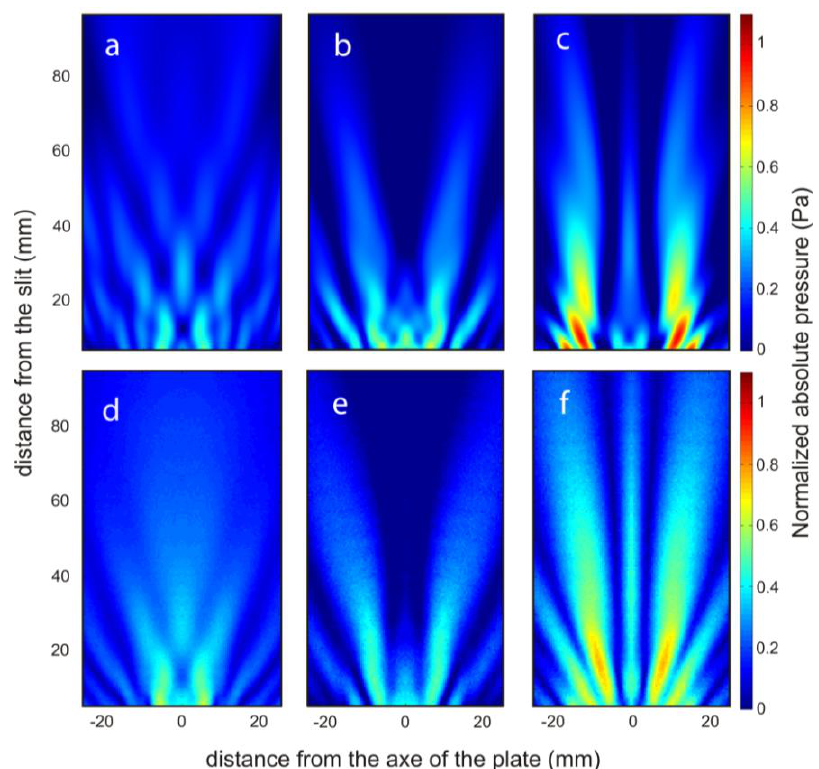
Figure 3. The normalized absolute pressure field maps in the XZ plane of the corrugated plates considered are shown. Simulated results for a groove depth of ( a ) 1 mm, ( b ) 2 mm and ( c ) 3 mm. Experimental results for a groove depth of ( d ) 1 mm, ( e ) 2 mm and ( f ) 3